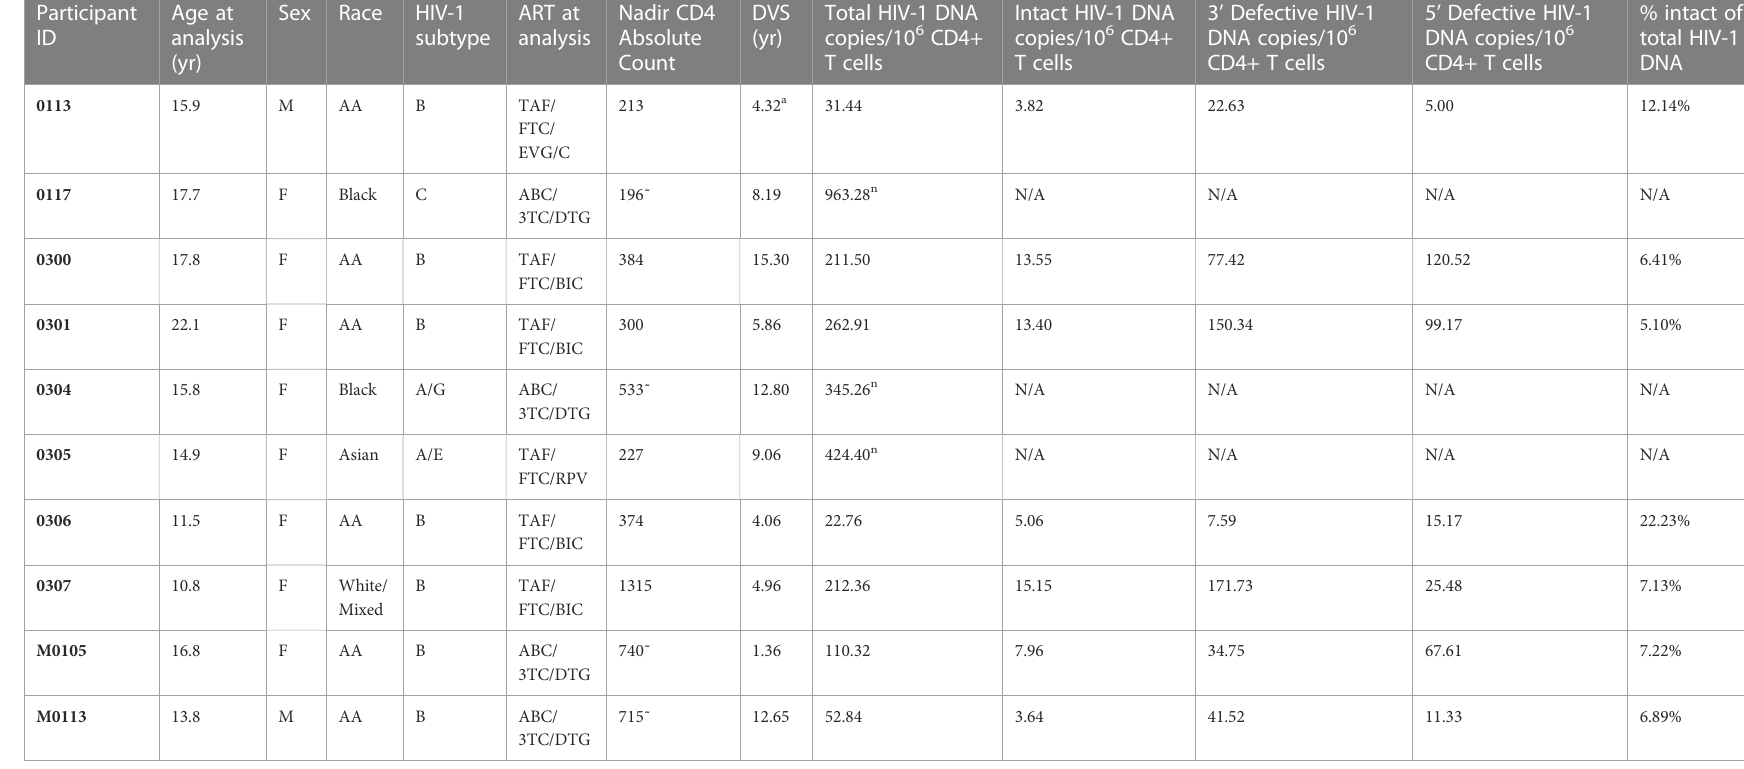
TABLE 1 Demographic and antiretroviral treatment histories, virologic and immunologic pro fi les of the study